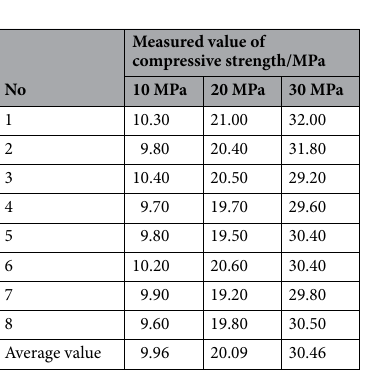
Table 1. Compressive strength test results of joint surface materials.